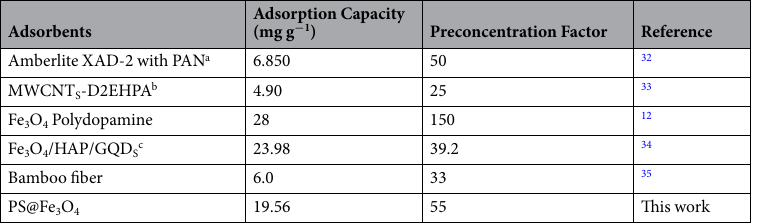
Table 3. Comparative data from some recent studies on copper adsorption. a 1-(2-pyridylazo) − 2-naphthol. b di- (2-ethyl hexyl phosphoric acid). c hydroxyapatite/graphene quantum